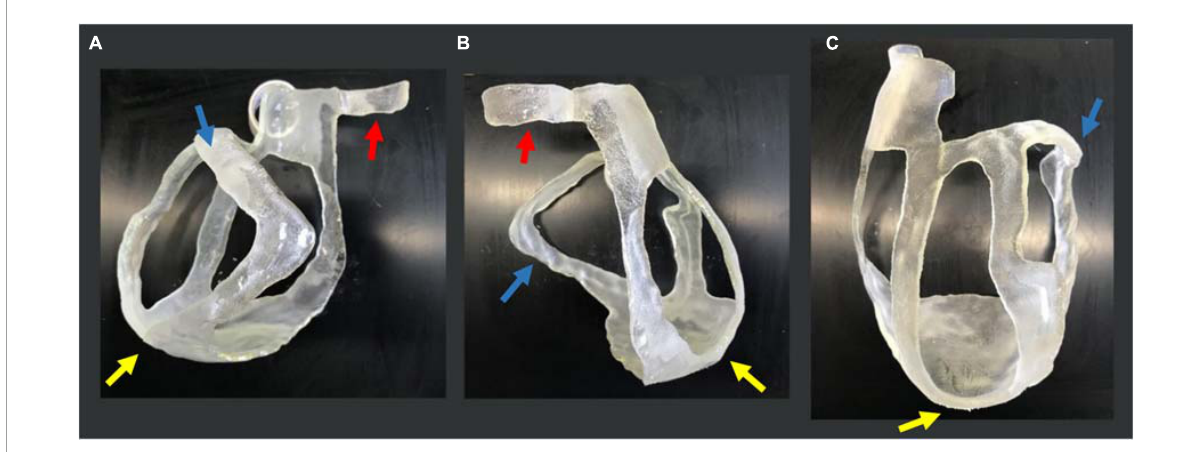
FIGURE8 3D-printed surgical guide prototype. Three views of the physical 3D surgical guide: (A) antero-posterior view; (B) latero-lateral view; and (C) postero-anterior view. The blue arrows indicate the thicker border for the target (scar) identification, the yellow ones indicate the apex, and the red ones the aorta annulus necessary for the application and positioning on the heart.